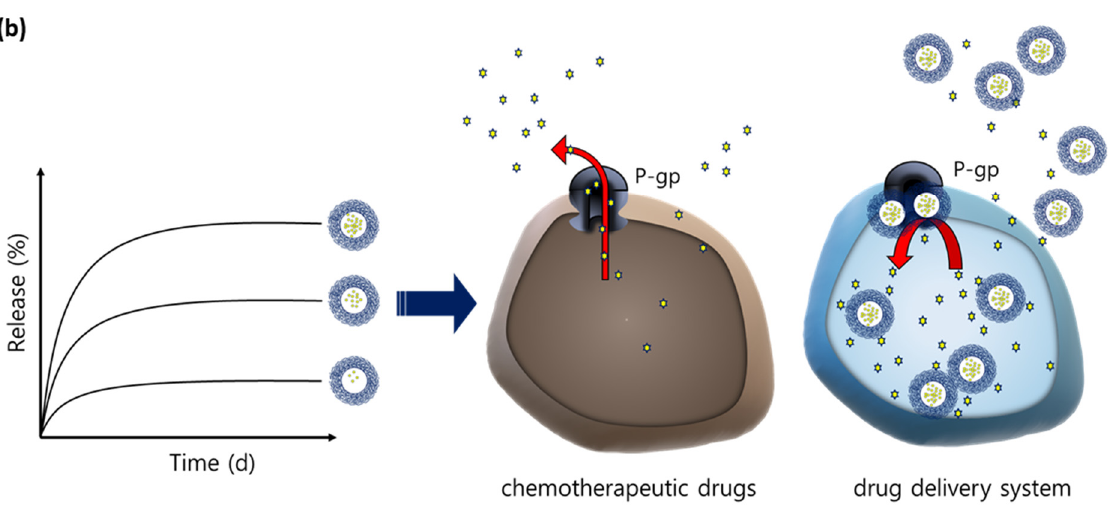
Figure 1. ( a ) Scheme of the characteristics and production yield of paclitaxel (PTX)–loaded TNPs (PTX@TNP) prepared using co–solvents at various ratios; ( b ) release profiles of PTX from TNPs with different loading contents, and mechanism of PTX@TNP–based chemotherapy in MDR-related colorectal cancer cells.